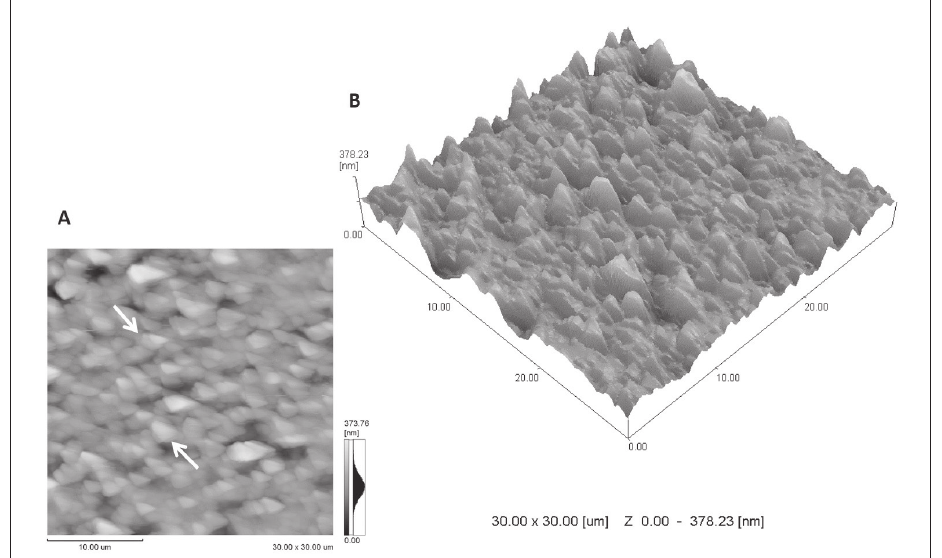
Figure 3 - AFM image